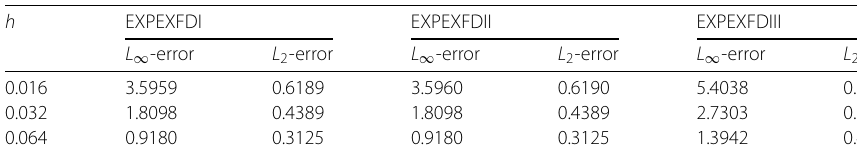
Table 4 The errors of the explicit exact finite difference schemes with (cid:3) t = 10 h h EXPEXFDI